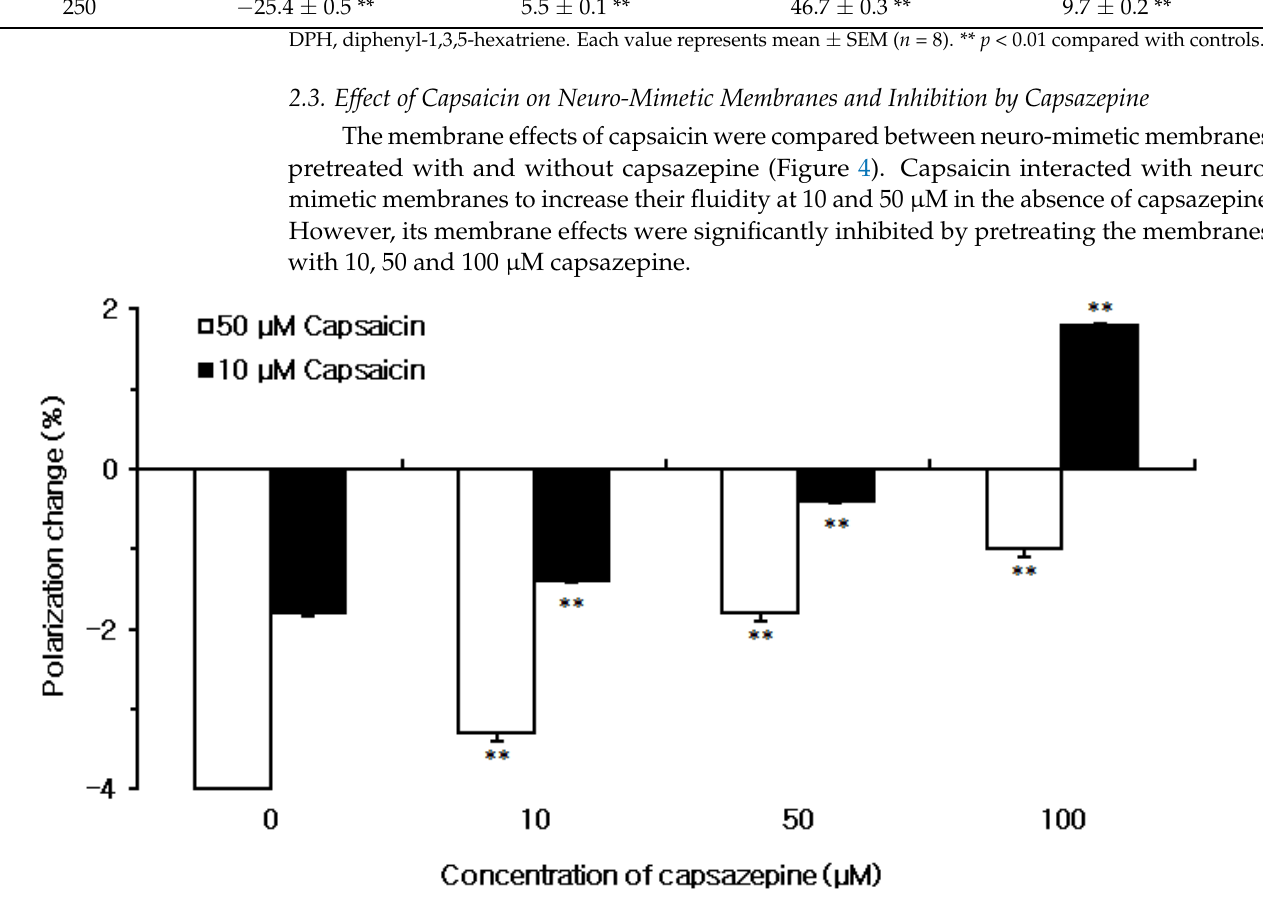
Figure 4. Effect of capsaicin on neuro-mimetic membranes and inhibition by capsazepine. Each value represents mean ± SEM ( n = 8). ** p < 0.01 compared with capsaicin alone.